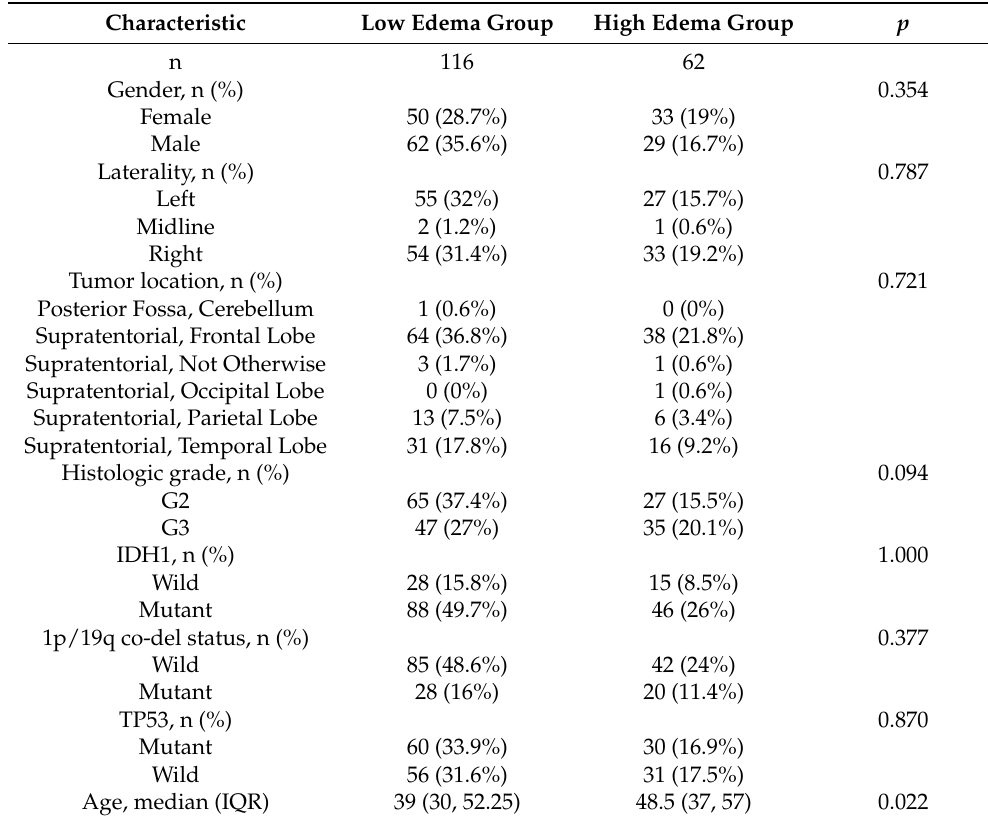
Table 1. Clinical characteristics of the two